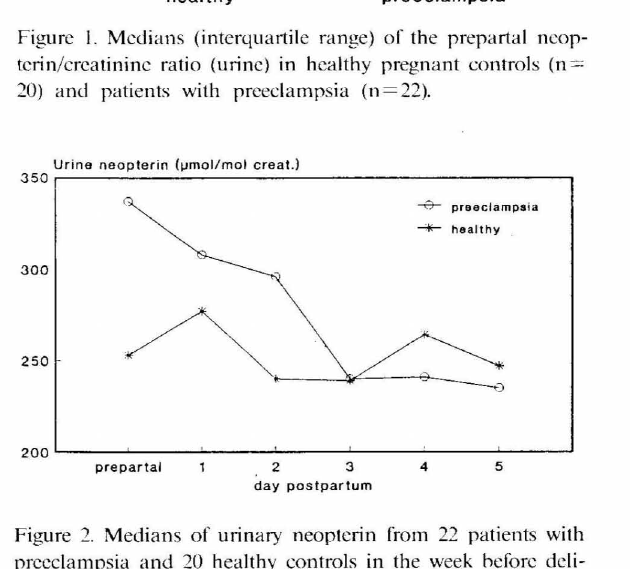
Figure 2. Medians of urinary neopterin from 22 patients with preeclampsia and 20 healthy controls in the week hcfore deli very and on each of the five postpartum